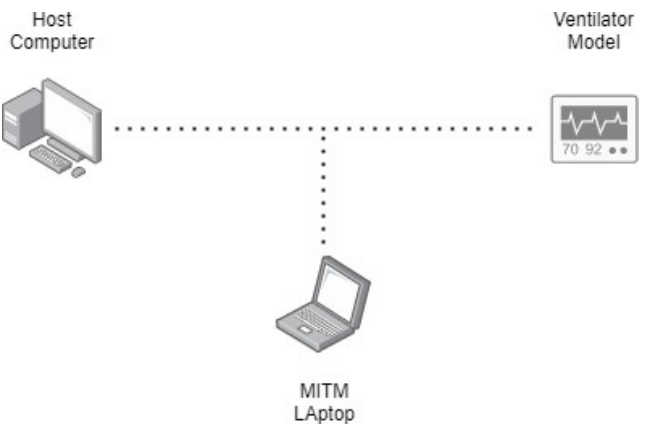
Figure 10. Man-in-the-middle attack